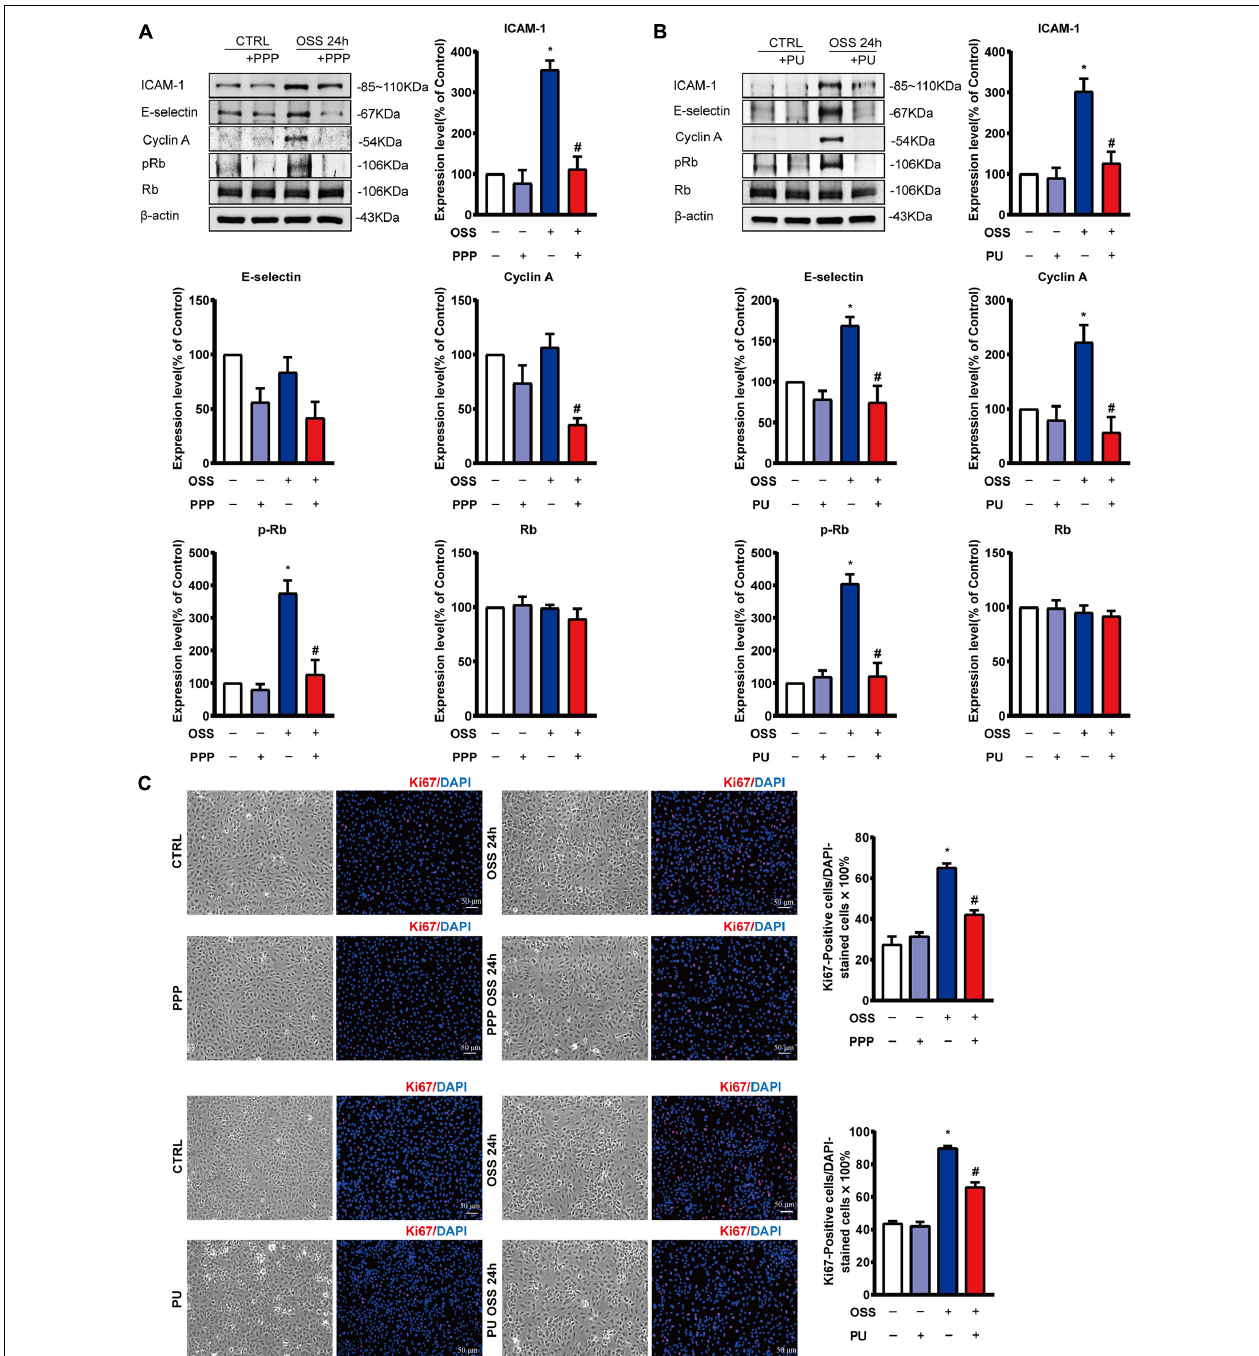
FIGURE 7 | PPP and PU inhibit pro-inflammatory responses and proliferation of ECs induced by OSS. (A,B) Western blot analysis and quantitative results of the effects of PPP (A) or PU (B) on the expression of pro-inflammatory molecules ICAM-1, E-selectin and cell cycle regulatory proteins Cyclin A and pRb/Rb in ECs. Blot is a representative of five independent experiments. Ki67 immunostaining indicates that PPP/PU. (C) Inhibits OSS-induced EC proliferation (five independent experiments performed). * P < 0.05 vs. Vehicle, # P < 0.05 vs. Model.